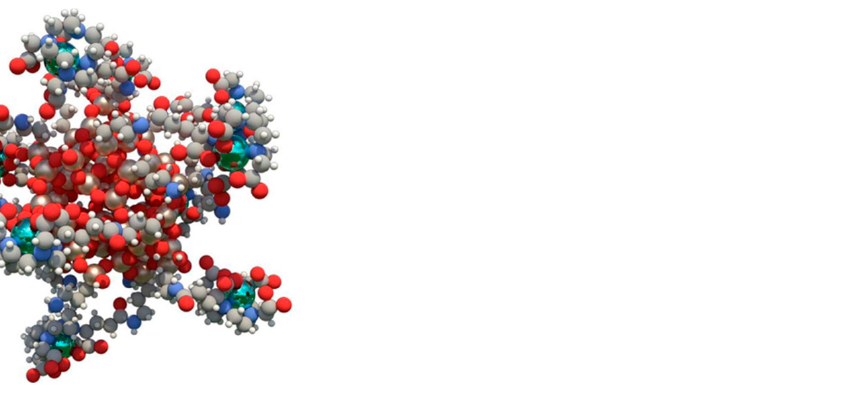
Figure 1 . AGuIX structure: Polysiloxane structure of AGuIX chelating gadolinium (green) via dodecane tetraacetic acid ligands. Figure reprinted from Lux et al. [21] .